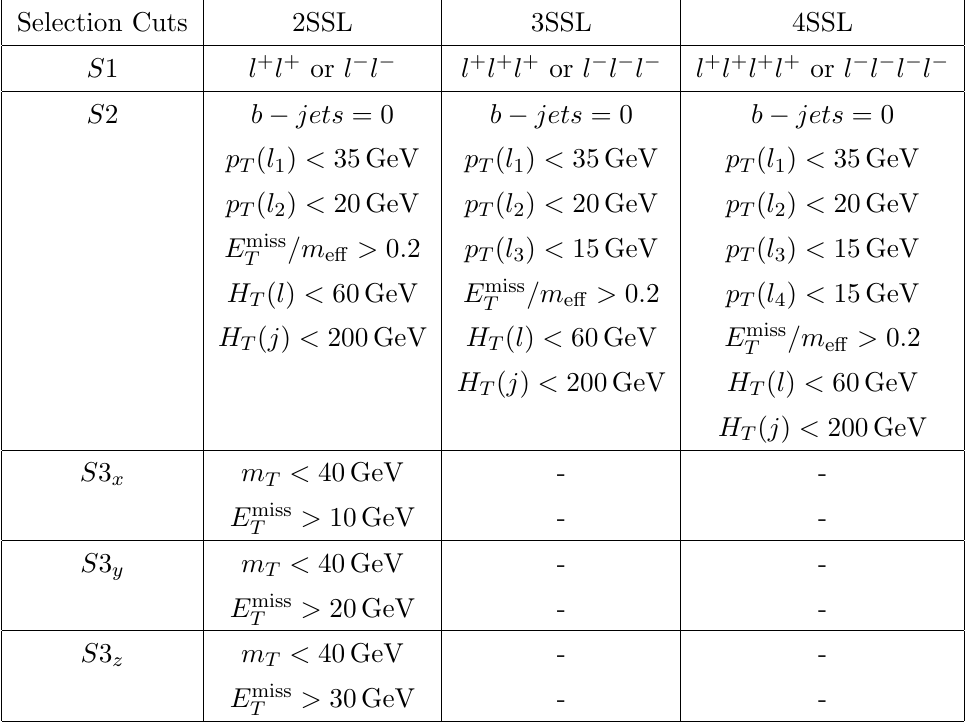
Table 3 . Selection criteria ( S 1, S 2, and S 3) that we consider for the 2SSL, 3SSL, and 4SSL channels. In selection S 1, we only consider the events with exactly 2, 3 or 4 leptons with same sign. Other events containing opposite sign leptons are vetoed. Here l = e; (cid:22) . Also, note that for the 3SSL and 4SSL channels, we do not impose selection criteria S